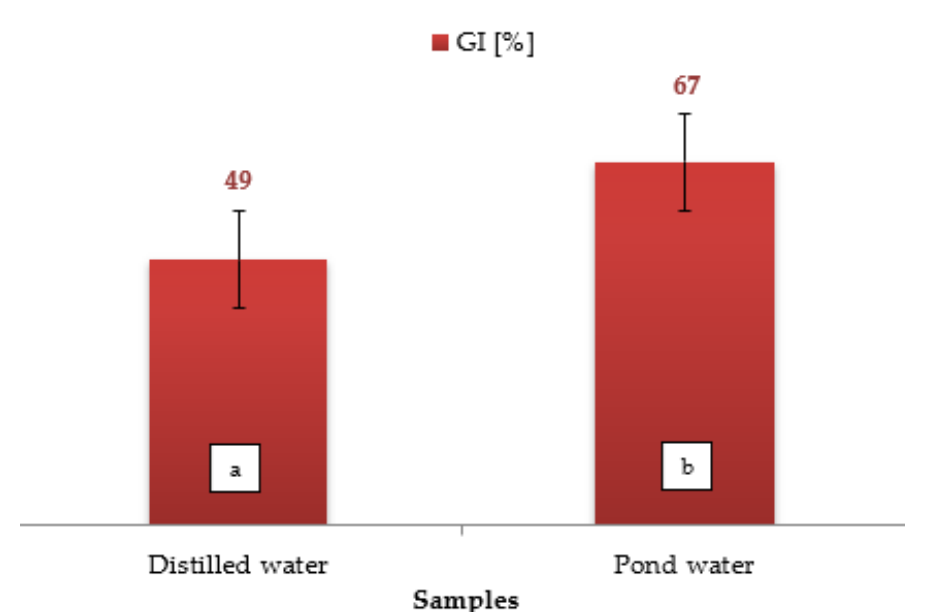
Figure 3. Germination index (GI) of Lepidium sativum L. in establishing the degree of phytotoxicity.